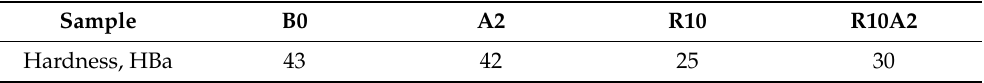
Table 2. Hardness of composite materials (average measurement) .